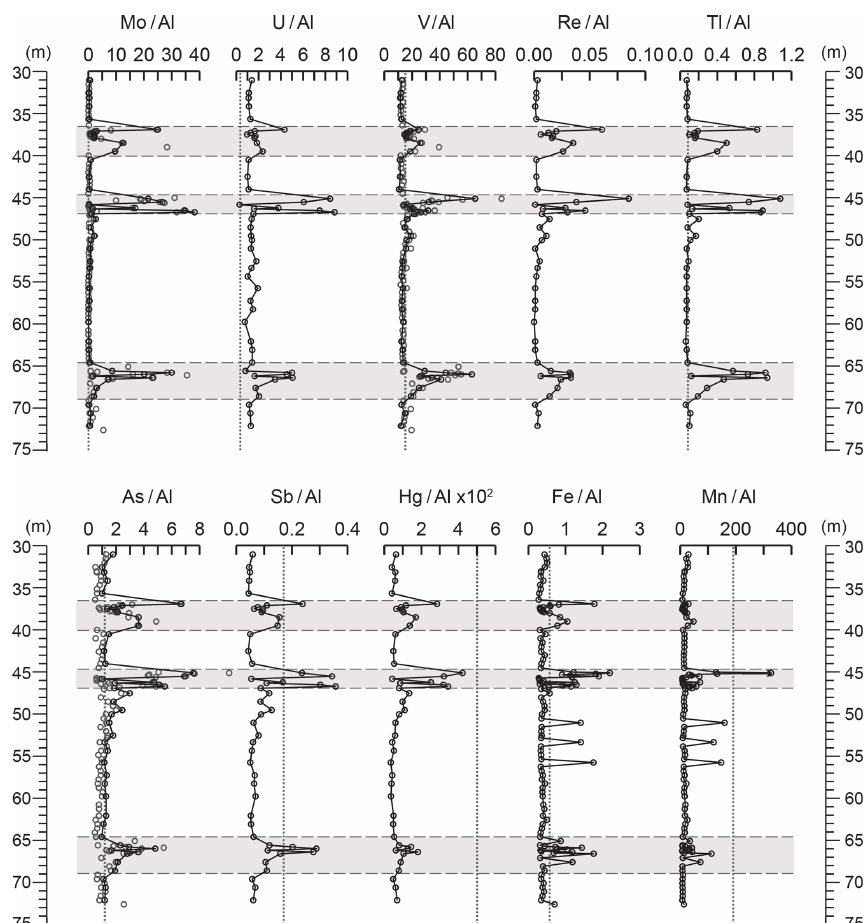
Figure 7. Depth plots of elemental ratios used as palaeoredox indicators. Mo / Al (ppm / wt%), U / Al (ppm / wt%), V / Al (ppm / wt%), Re / Al (ppm / wt%), Tl / Al (ppm / wt%), As / Al (ppm / wt%), Sb / Al (ppm / wt%), Hg / Al × 10 2 (ppm / wt%), Fe / Al (wt% / wt%), and Mn / Al (ppm / wt%). Grey panels depict the higher-variability mudstone intervals (HVMIs) defined in this study. Where grey and black circles are seen on the same plot, grey circles mark the XRF data and black circles mark the ICP-MS